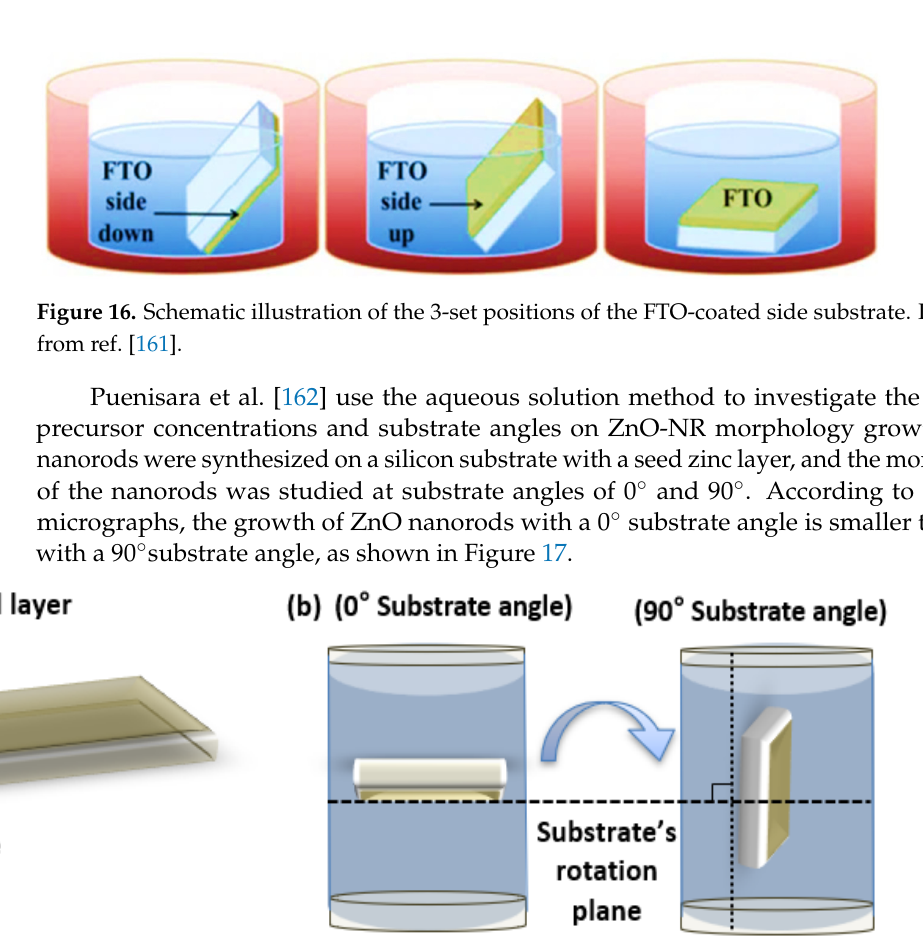
Figure 17. ( a , b ) ZnO nanorods growth prepared on the substrate for 0° and 90° substrate angles. Reprinted from ref. [162].